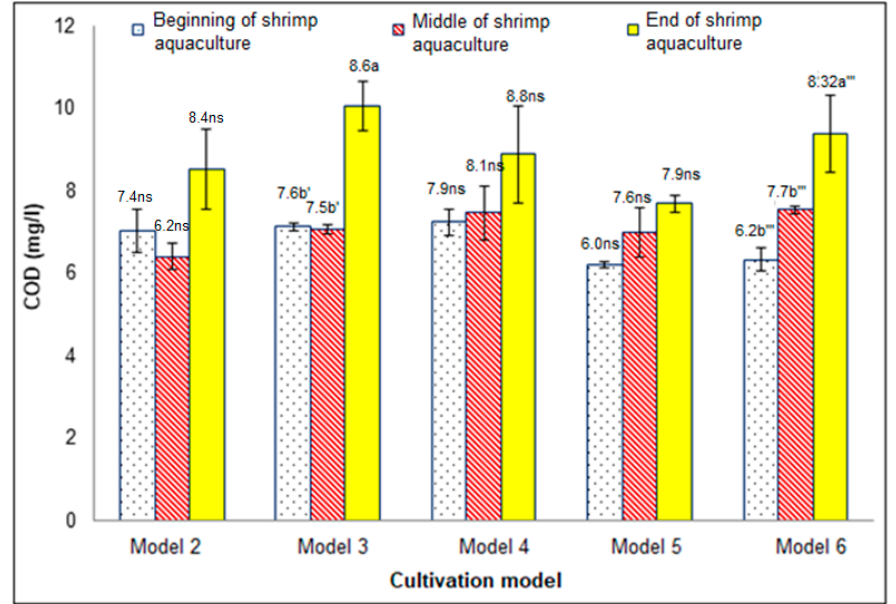
Figure 8. Fluctuations in chemical oxygen demand (COD) content in farming models. Notes: a and b are compared according to sampling time, the same letters within the same column or row have no significant difference. The symbols ‘, ‘’’ are used to distinguish different experimental or model areas. ns: no difference (compared at a significance level of 5%).